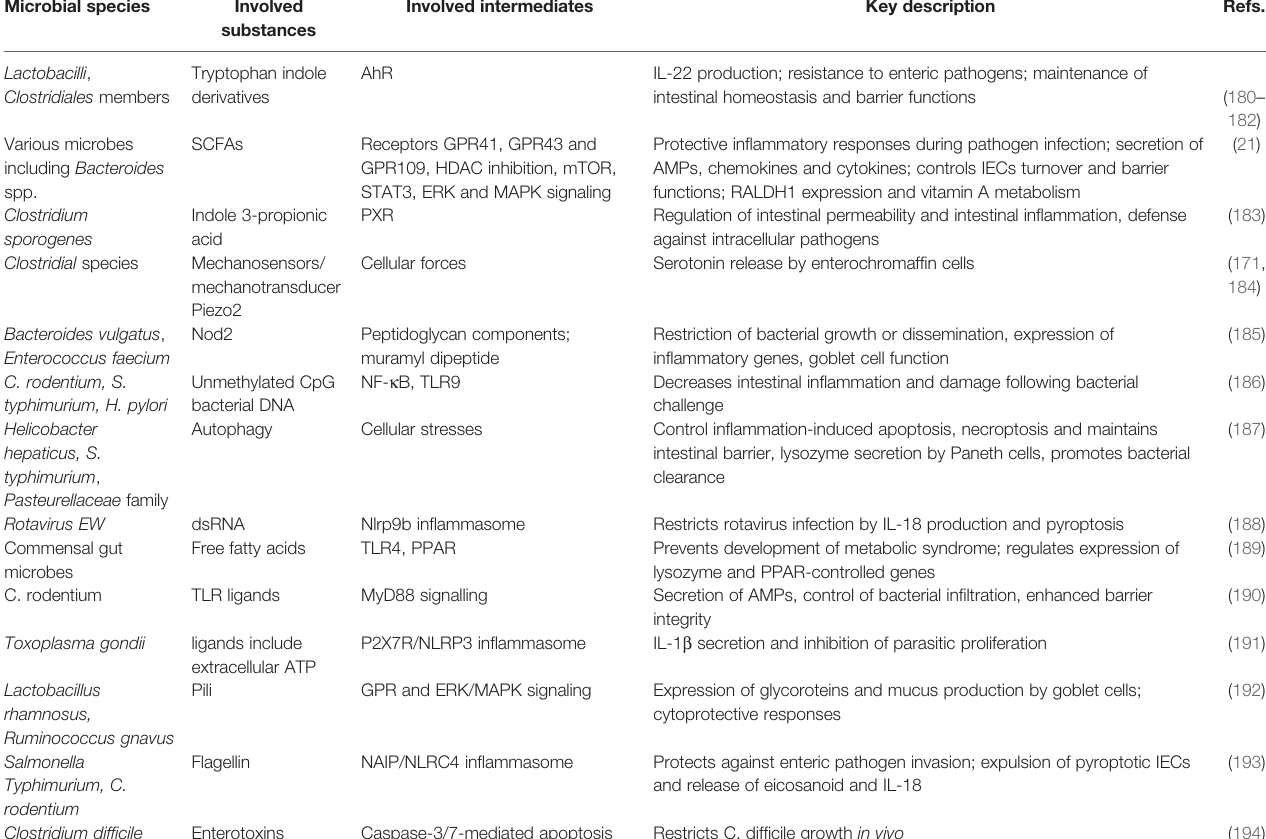
TABLE 5 | Identi fi ed gut microbes regulating intestinal mucosal